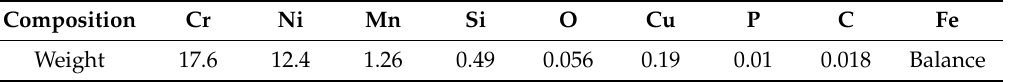
Table 1. Powder composition of the 316L for the LBM process (wt.%).